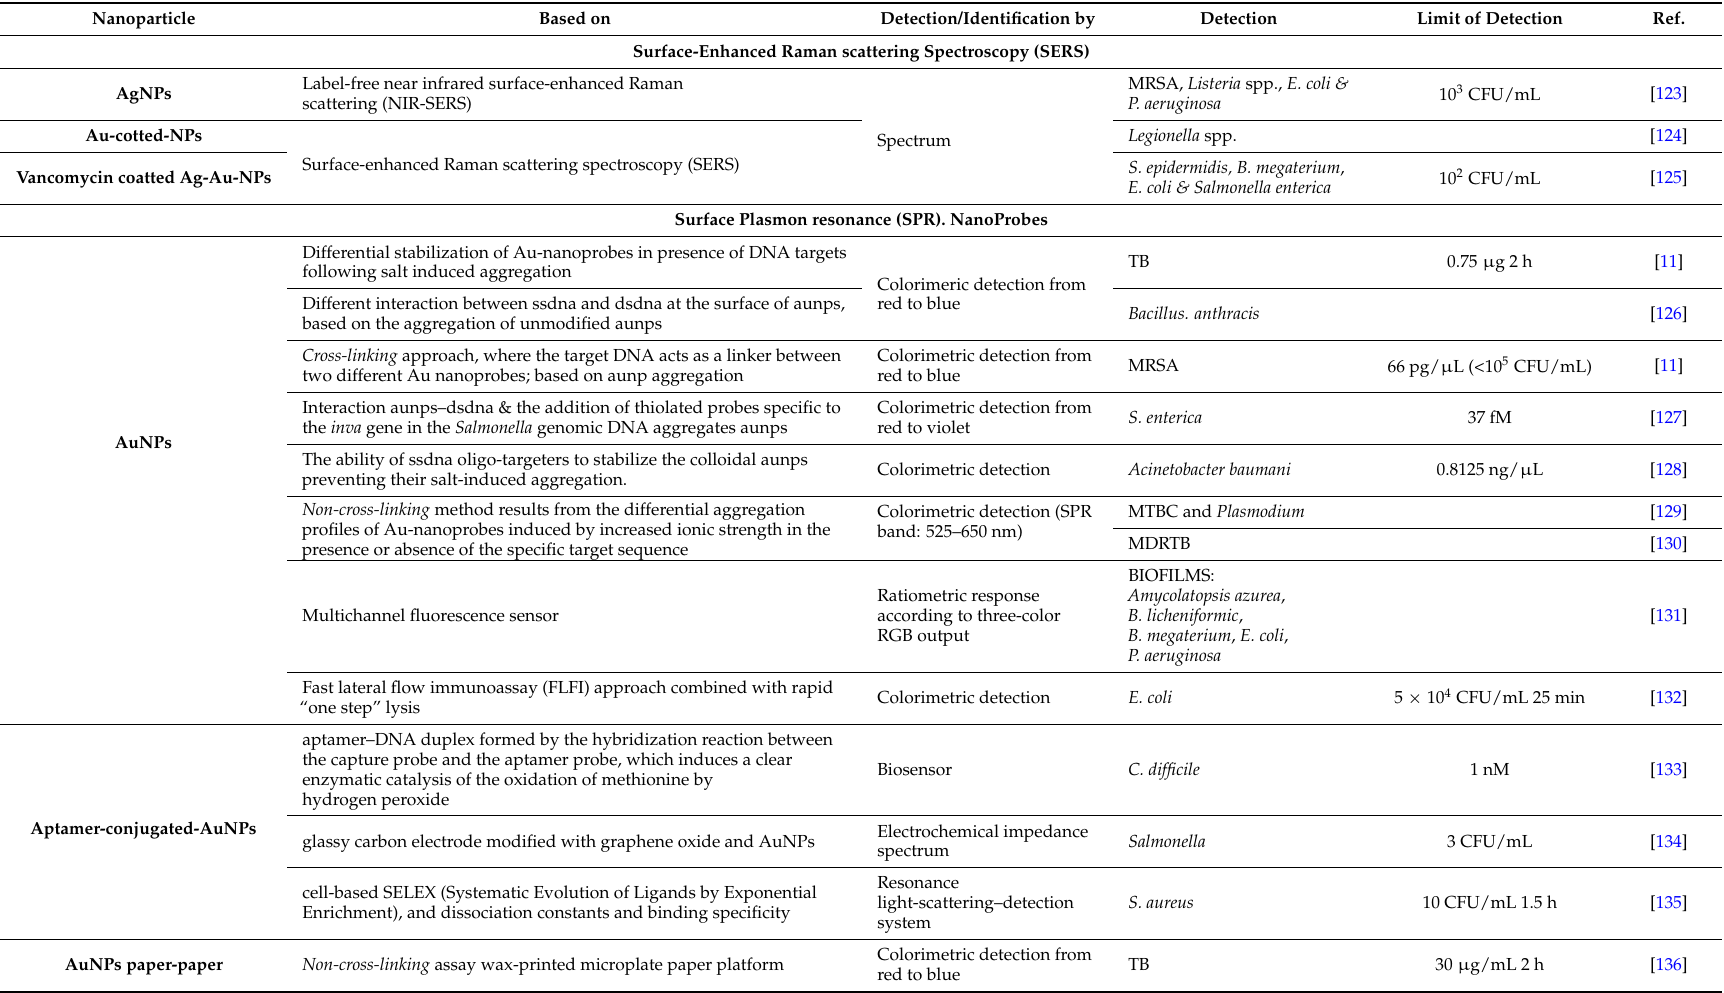
Table 2. Microbiological diagnosis approach by inorganic